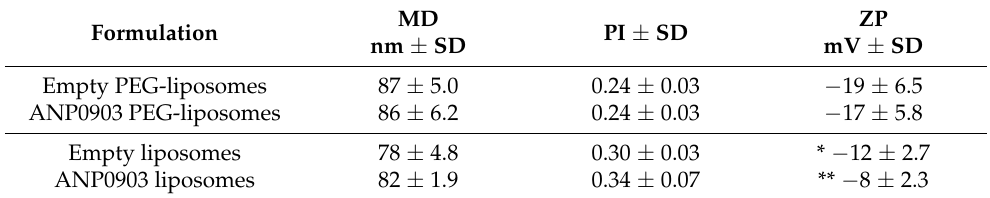
Table 1. Characteristics of empty and ANP0903 PEG-liposomes and non-PEGylated liposomes: mean diameter (MD), polydispersity index (PI), and zeta potential (ZP). Each value represents the mean ± SD ( n > 10); * and ** values statistically different ( p < 0.05 and p < 0.01, respectively) from empty PEG-liposomes and ANP0903 PEG-liposomes, respectively. ZP MD PI ± SD Formulation mV ± SD nm ± SD Empty PEG-liposomes 87 ± 5.0 0.24 ± 0.03 − 19 ± 6.5 ANP0903 PEG-liposomes 86 ± 6.2 0.24 ± 0.03 − 17 ± 5.8 Empty liposomes 78 ± 4.8 0.30 ± 0.03 * − 12 ± 2.7 ANP0903 liposomes 82 ± 1.9 0.34 ± 0.07 ** − 8 ± 2.3